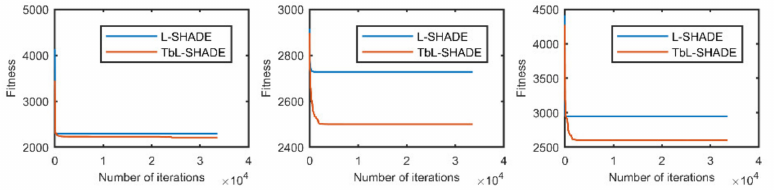
Figure 6. The selected average convergence of L-SHADE and TbL-SHADE is compared on CEC2020 in 10 D . From left to right f8, f9 and f10.